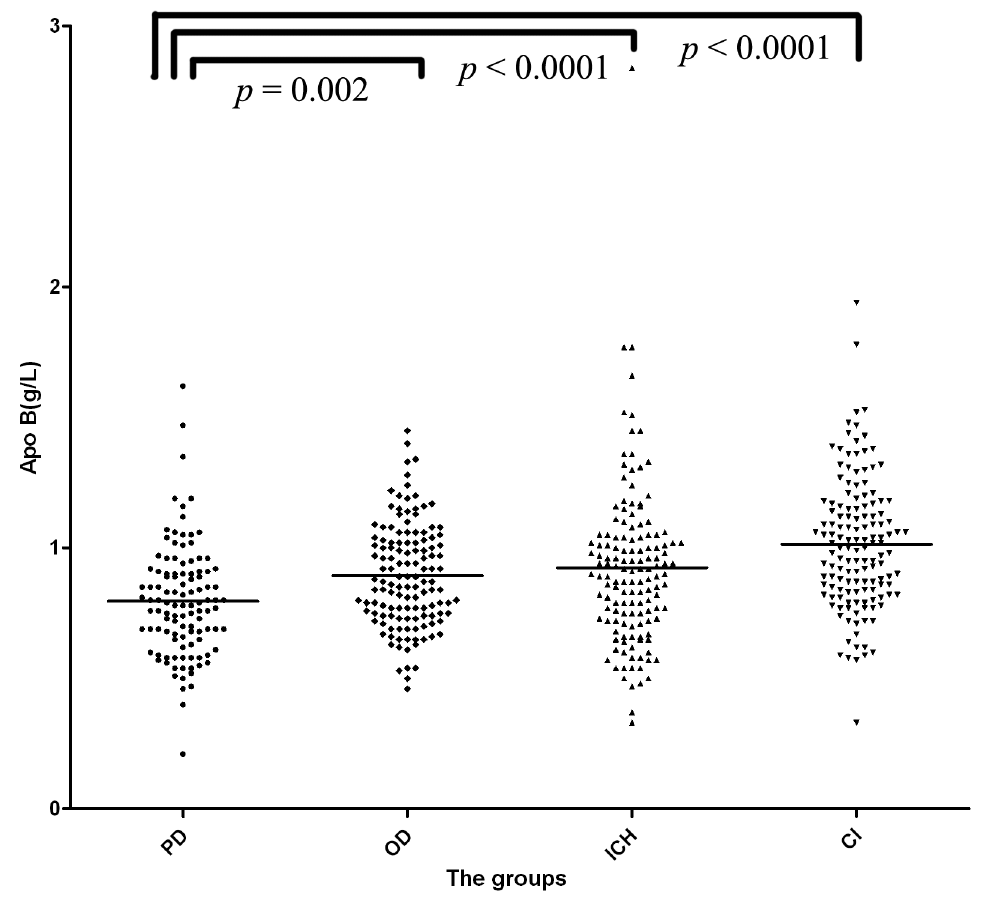
Figure 3. The serum level of apolipoprotein B (apo B) in the four groups. There was a significantly lower serum level of apolipoprotein B (apo B) in PD group than in OD ( p =0.002), ICH ( p <0.0001) and CI ( p <0.0001) groups. PD: Parkinson’s disease group; OD: other non-cerebrovascular neurological diseases group; ICH: intracerebral hemorrhage patients group; CI: cerebral infarction patients group. doi: